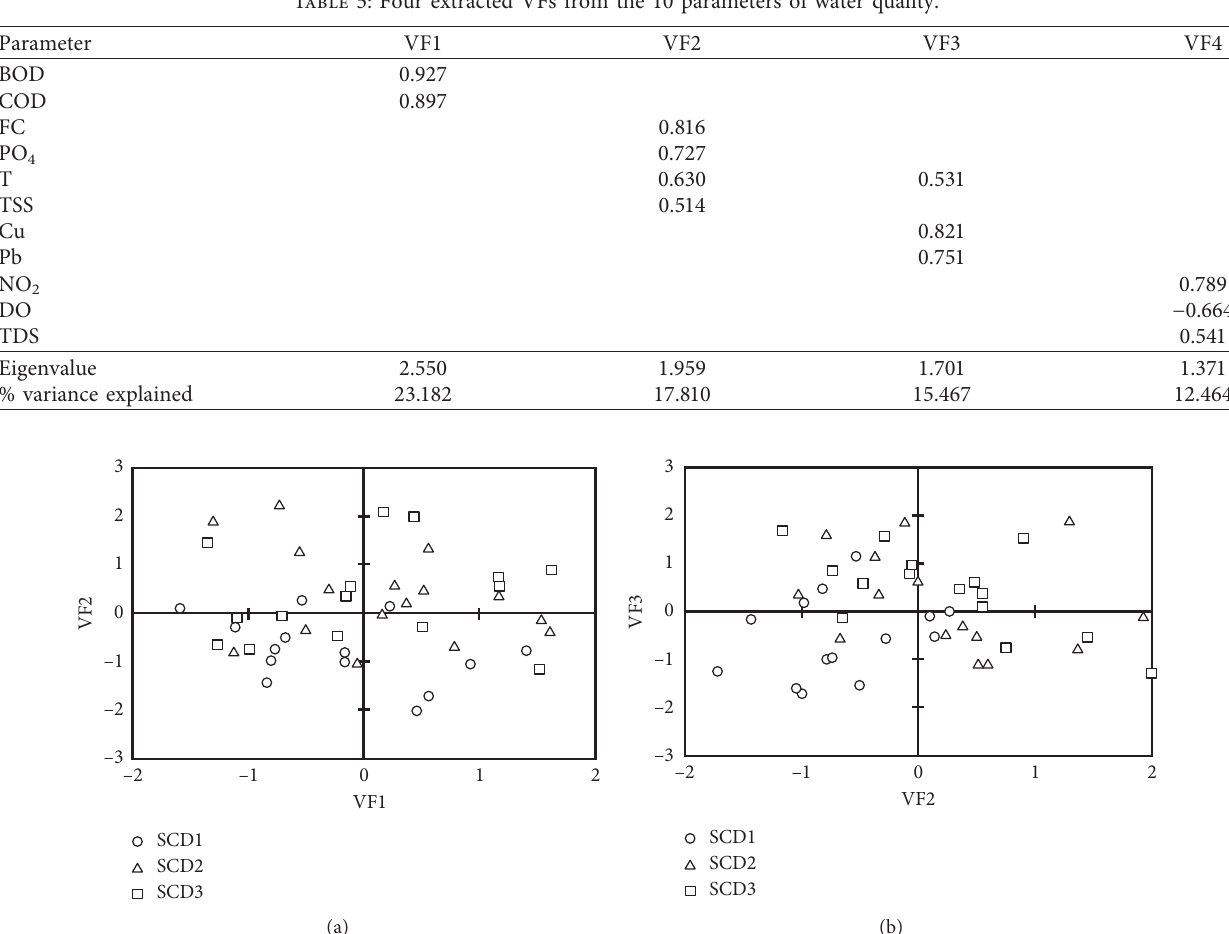
Table 5: Four extracted VFs from the 10 parameters of water quality.